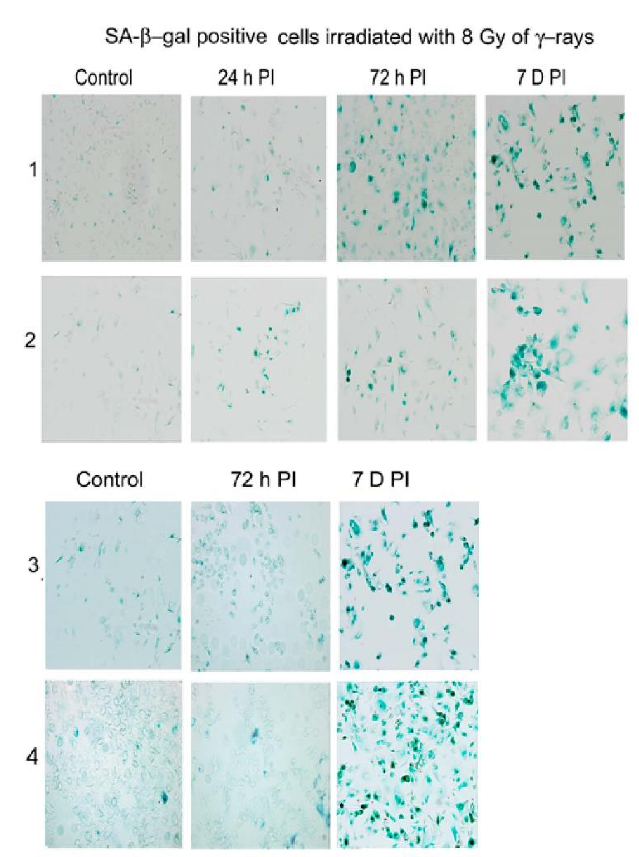
Figure 2. Activity of SA- β -galactosidase in MCF7, U2OS, MCF7-LBR(-) and U2OS-LBR(-) cells after the irradiation with 8 Gy of γ -rays. (1) MCF7, (2) U2OS, (3) MCF7-(LBR-), (4) U2OS-LBR(-). PI—post irradiation.